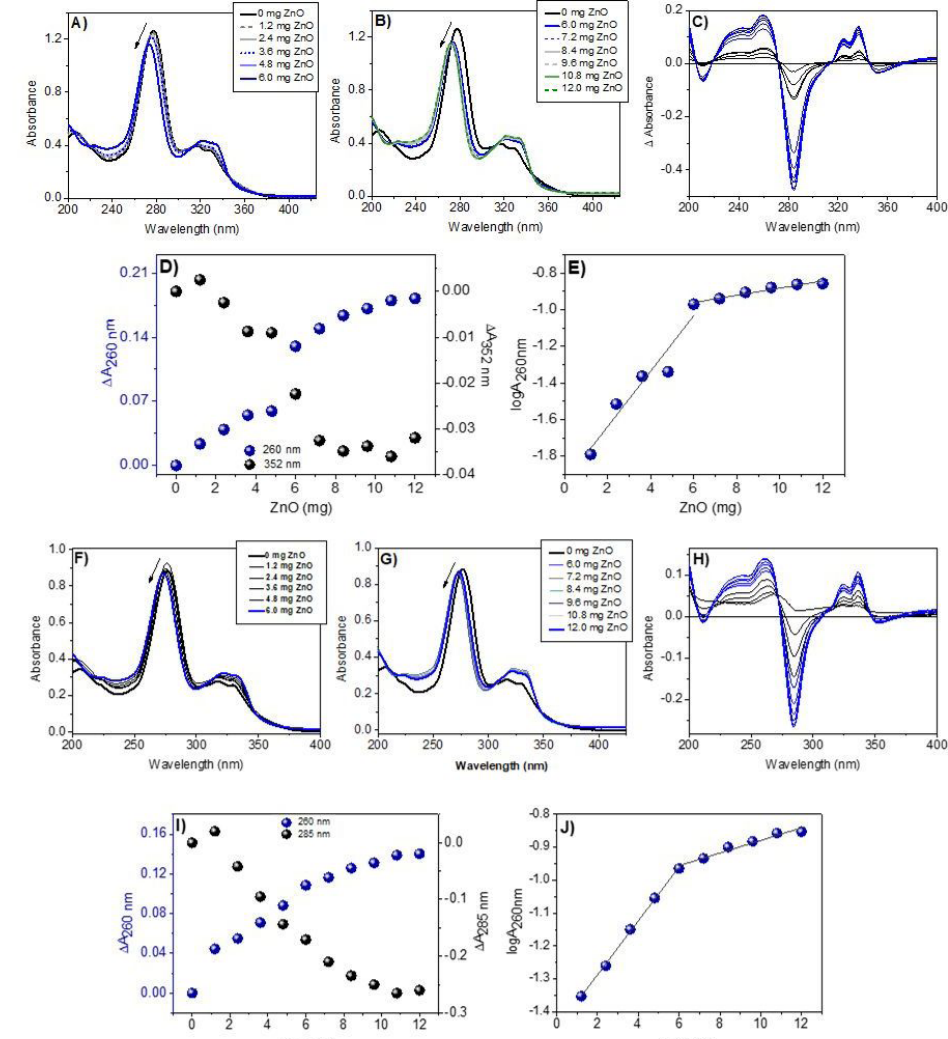
Figure 4. Changes in the CIPRO spectrum promoted by the interaction with ZnO and Cu-ZnO materials. A-B) and F-G) CIPRO photobleaching promoted by titration with ZnO and Cu-ZnO, respectively. The spectra obtained by titration with 0.012 to 0.06 mg/mL of ZnO and Cu-ZnO is shown in A and F, respectively, and B and G show the spectra obtained with 0.06 to 0.12 mg/ mL of ZnO and Cu-ZnO. C) and H) shows the corresponding differential spectra for ZnO and Cu-ZnO titration; D) and I) show the spectral changes at 260 and 285 nm and E) and J) the corresponding linearization by using logA 260 nm